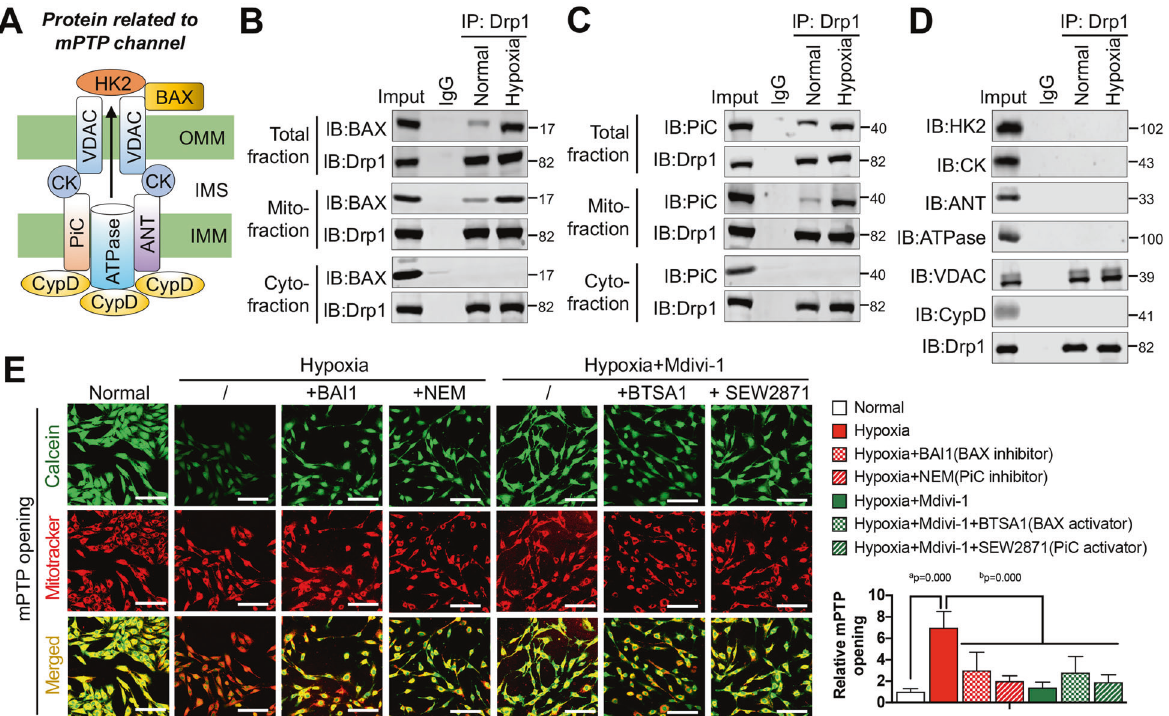
Fig. 2 Mitochondrial Drp1 recognizes mPTP channels through binding with BAX and PiC after hypoxia. A The schematic diagram showing the proteins related to mPTP channel under current cognition. B Co-IP results for the combination of Drp1 and BAX in total, cytoplasmic and mitochondrial fractions of VSMCs after hypoxia. C Co-IP results for the combination of Drp1 and PiC in total, cytoplasmic and mitochondrial fractions of VSMCs after hypoxia. D Co-IP results for the combination of Drp1 and other mPTP related proteins, including HK2, CK, ANT, ATPase, VDAC and CypD, after hypoxia. E Representative confocal images of mPTP opening in VSMCs after hypoxia and Mdivi-1 (50 μ M) treatment under intervening BAX or PiC (bar, 100 μ m). BAX inhibitor: BAX activation inhibitor 1 (BAI1, 5 μ M), PiC inhibitor: N-Ethylmaleimide (NEM, 5 μ M), BAX activator: BAX trigger site activator 1 (BTSA1, 15 μ M), PiC activator: spingosine-1 phosphate receptor agonist (SEW2871, 15 nM). Relative mPTP opening ratio ( fl uoresce intensity of MitoTracker/Calcein) in each group was calculated by Image J ( n = 5 samples/group). a: P < 0.05 compared with Normal group, b: P < 0.05 compared with Hypoxia